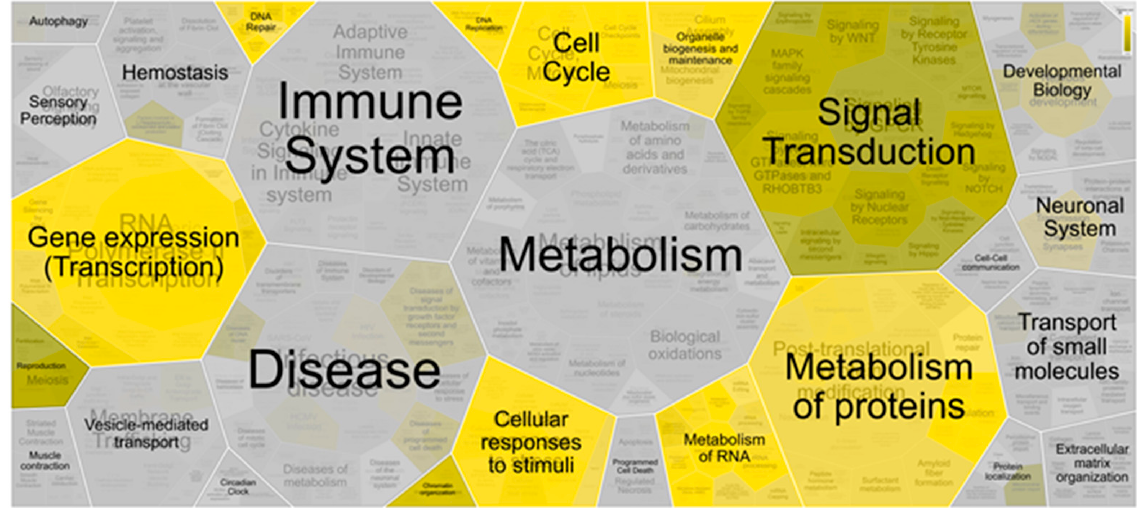
Figure 4. Pathway involvement of critical genes in the regulatory network. Tumor recurrence genes were involved in pathways related to various activities; these genes had the highest involvement in signal transduction and protein metabolism. When genes are matched and significantly overrepresented in a pathway ( p < 0.05), the pathway is indicated in a yellow to dark yellow gradient ( p is from 0 to 0.05). Table 2. Expression fold change of GBM recurrence-associated biomarkers between regions and risk groups. Tumor Margin Relative to Tumor Mass (Diff.